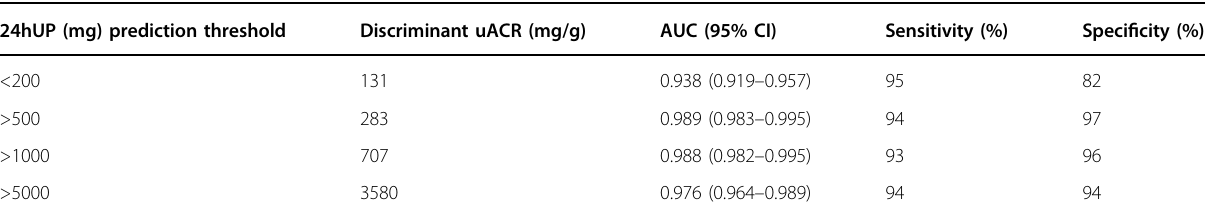
Table 3 ROC analysis using uACR to predict 24hUP in systemic AL amyloidosis patients ( n = 575). 24hUP (mg) prediction